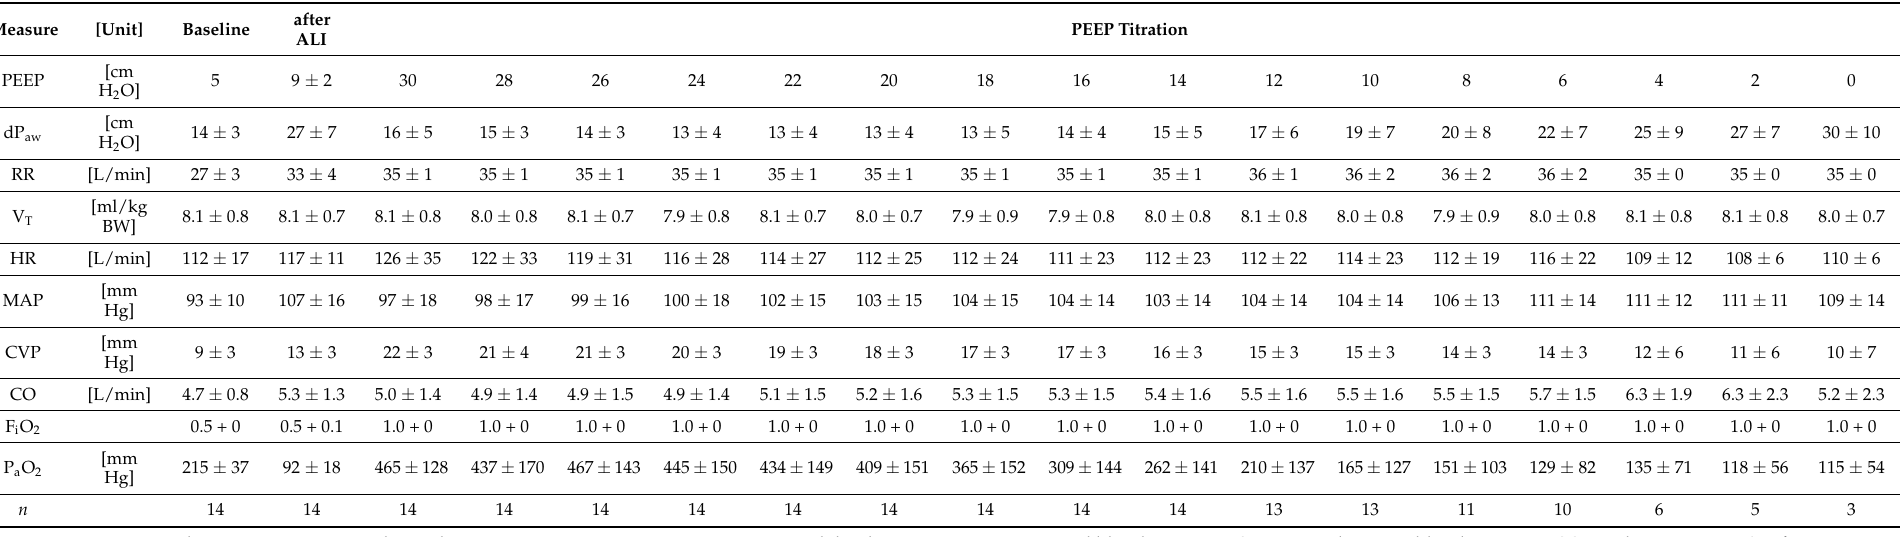
Table 1. Cardiorespiratory effects of lung injury induction and decremental PEEP